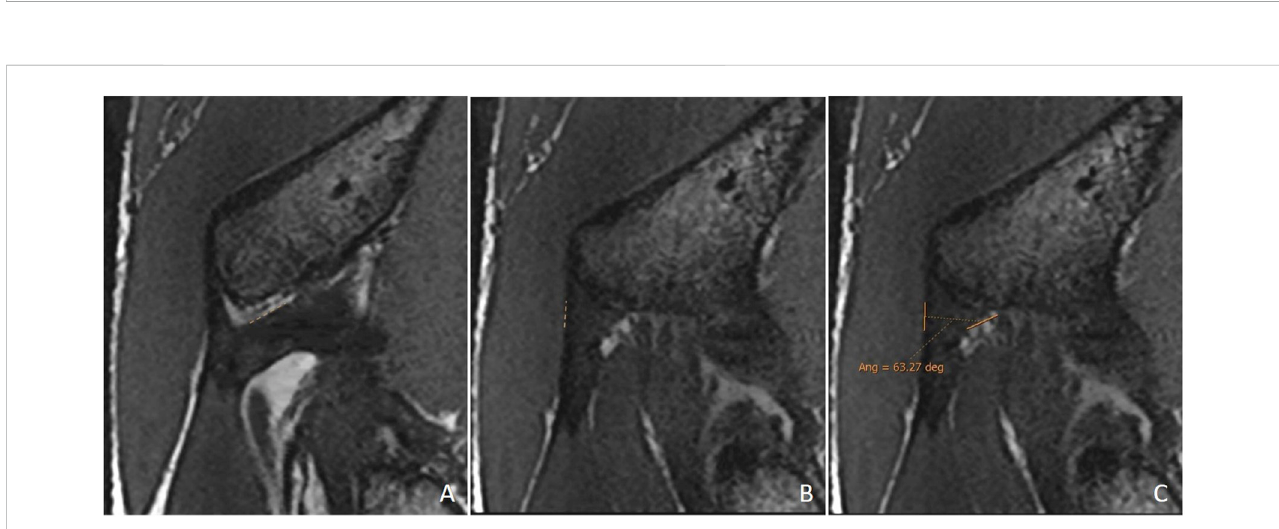
FIGURE 4 Double oblique sagittal 3D proton density sections. (A) Lateral section of the indirect tendon with the cranial margin of the IT (indirect tendon line of the angle). (B) Middle line section of the direct tendon with the anterior margin of the tendon draughted (direct tendon line of the angle) and (C) resulting direct – indirect tendon